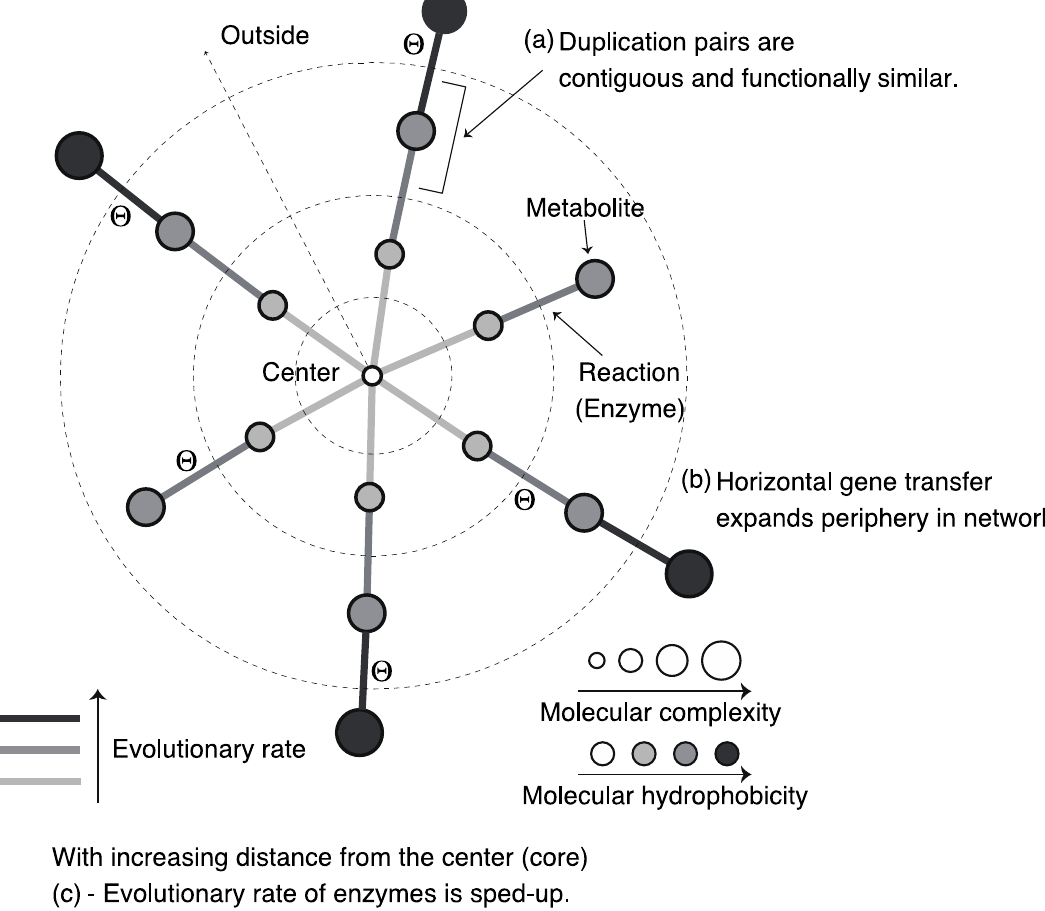
Figure 4. Schematic diagram of the roles and properties of enzymes and metabolites in metabolic